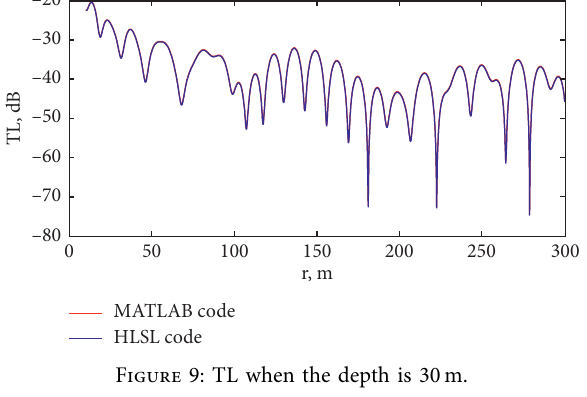
Figure 9: TL when the depth is 30 m.